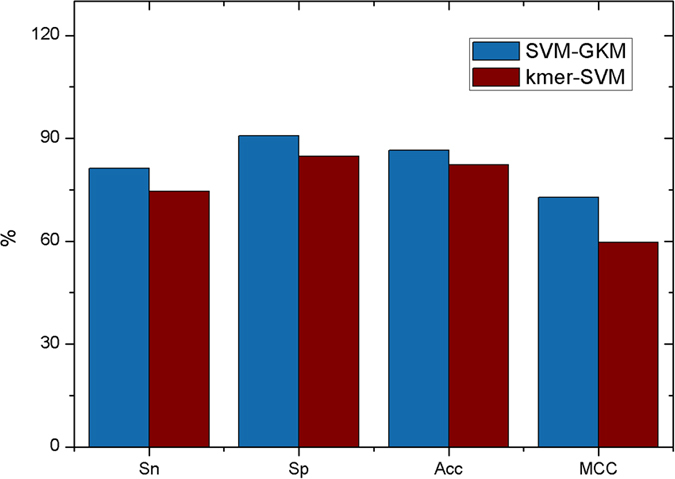
Comparison of SVM-GKM and kmer-SVM with four performance measures.This figure shows the best results that SVM-GKM and kmer-SVM achieved, where word length k = 13 and matches length m = 7 for SVM-GKM, and word length k = 10 for kmer-SVM. SVM-GKM outperforms kmer-SVM in terms of all the four performance measures.